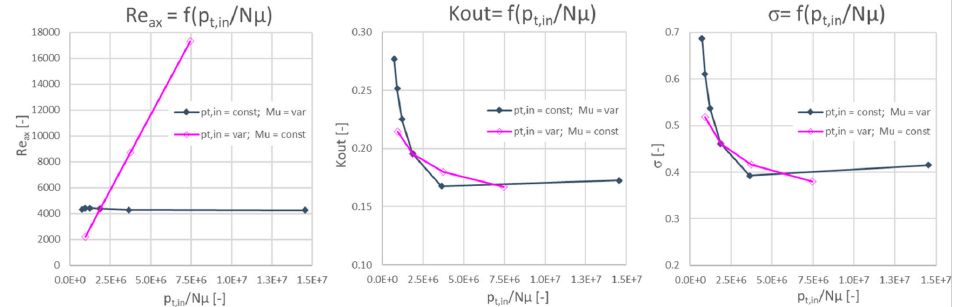
Figure 9. Influence of pt in / N µ on axial Reynolds number, outlet swirl ratio, and windage